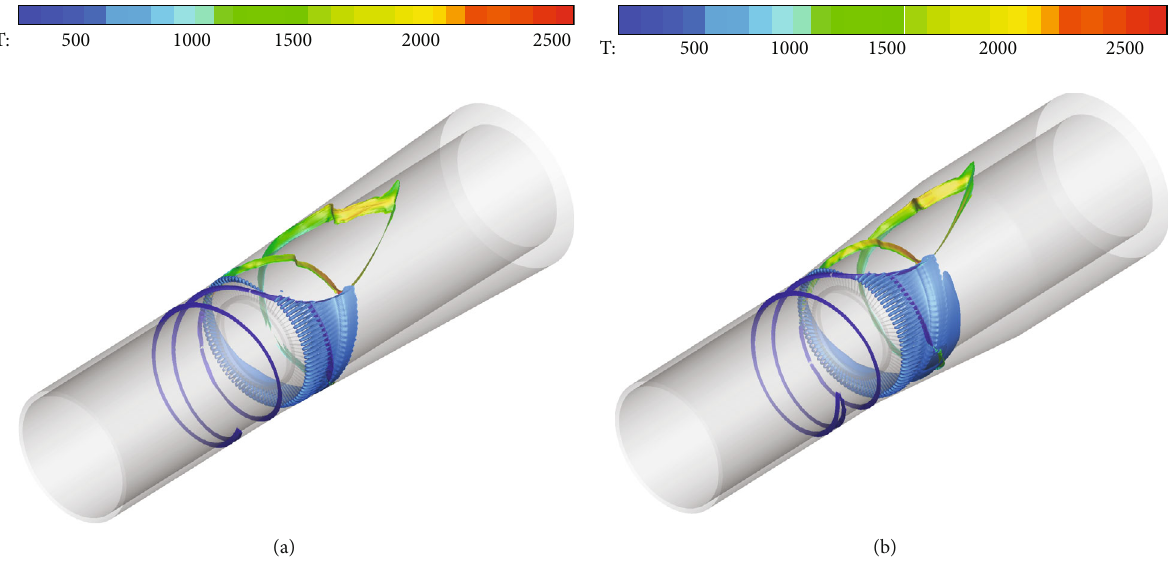
Figure 3: Instantaneous isosurfaces of pressure colored by temperature (K) and isosurfaces of H